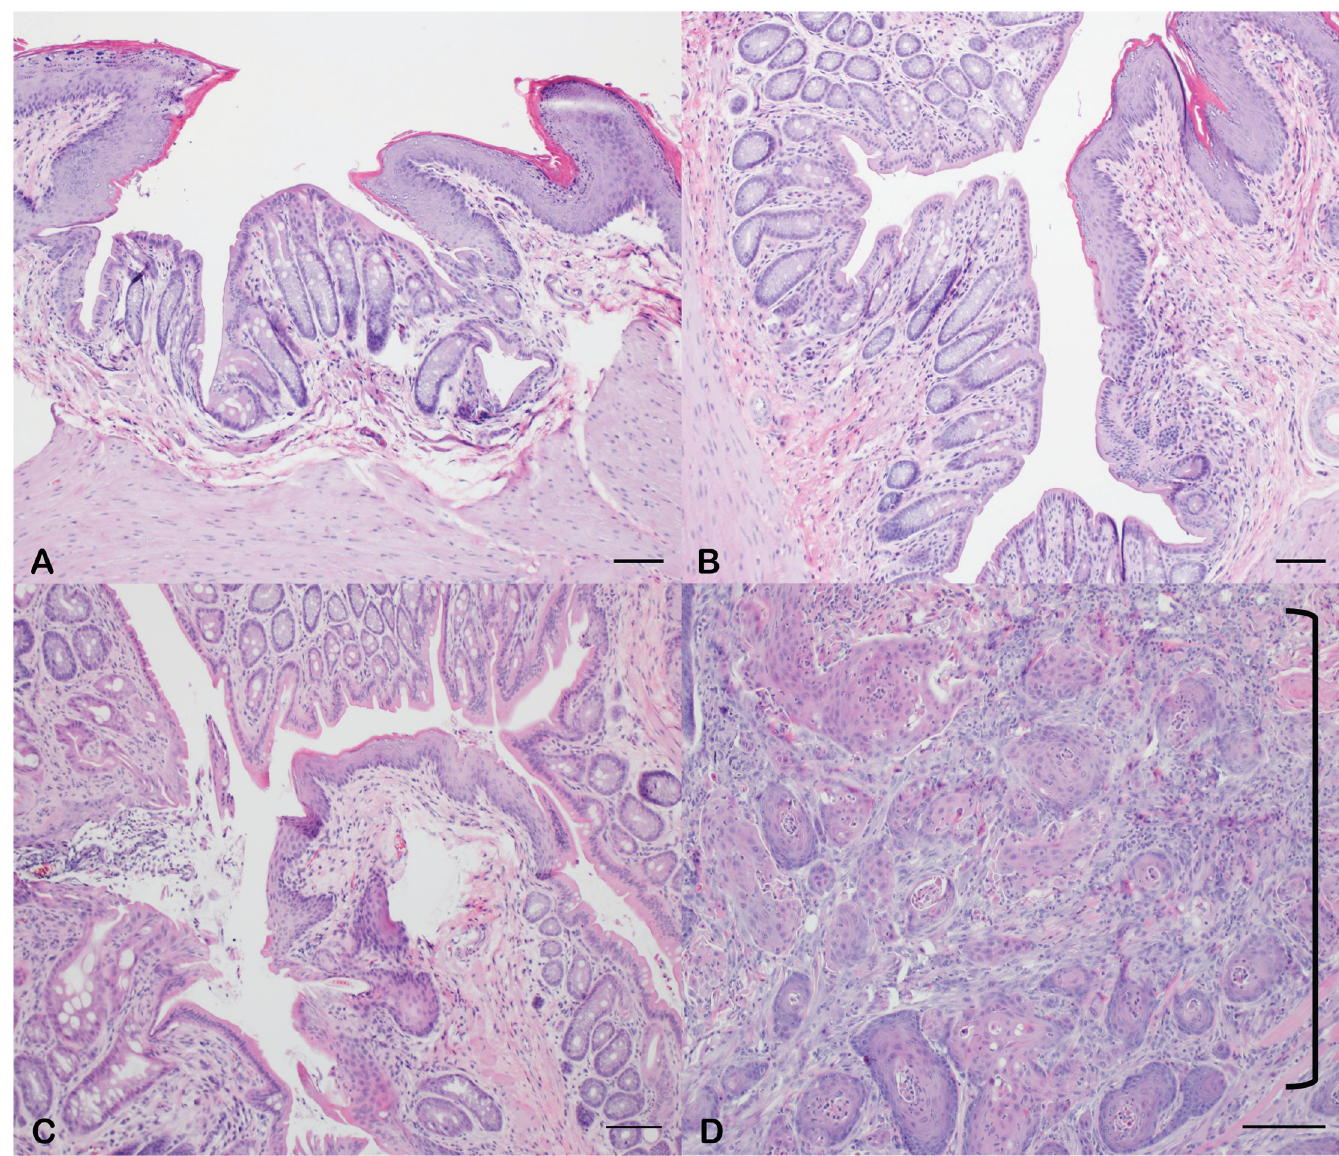
Fig 1. Anal tumor development in KC mice. At age 9 months, anorectal tissue was excised for histological analysis. In male (A) and female (B) C57BL/6J wild type mice, normal anorectal histology was present. Additionally, 9-month-old KC male mice (C) demonstrated normal anorectal histology. In contrast, large perianal tumors were grossly evident in 9-month-old female KC mice with invasive anal SCC present on histologic examination. This is indicated by the bracket (D). Scale bars equal 200 μ m.